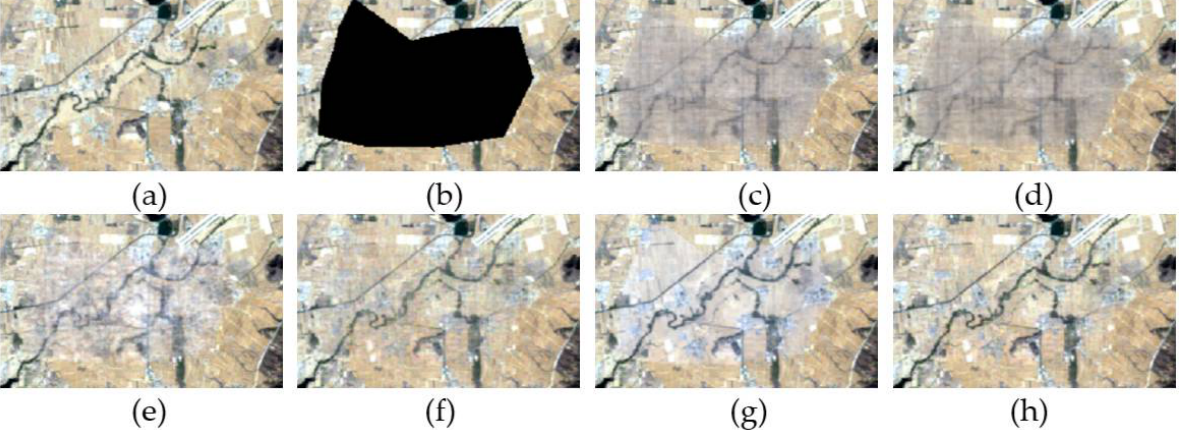
Figure 8. Enhanced details from Figure 7a–h: ( a ) original image; ( b ) simulated cloudy image; ( c – h ) reconstructed images of HaLRTC, AWTC, NL-LRTC, TVLRSD, ST-Tensor and FMTC algorithms,